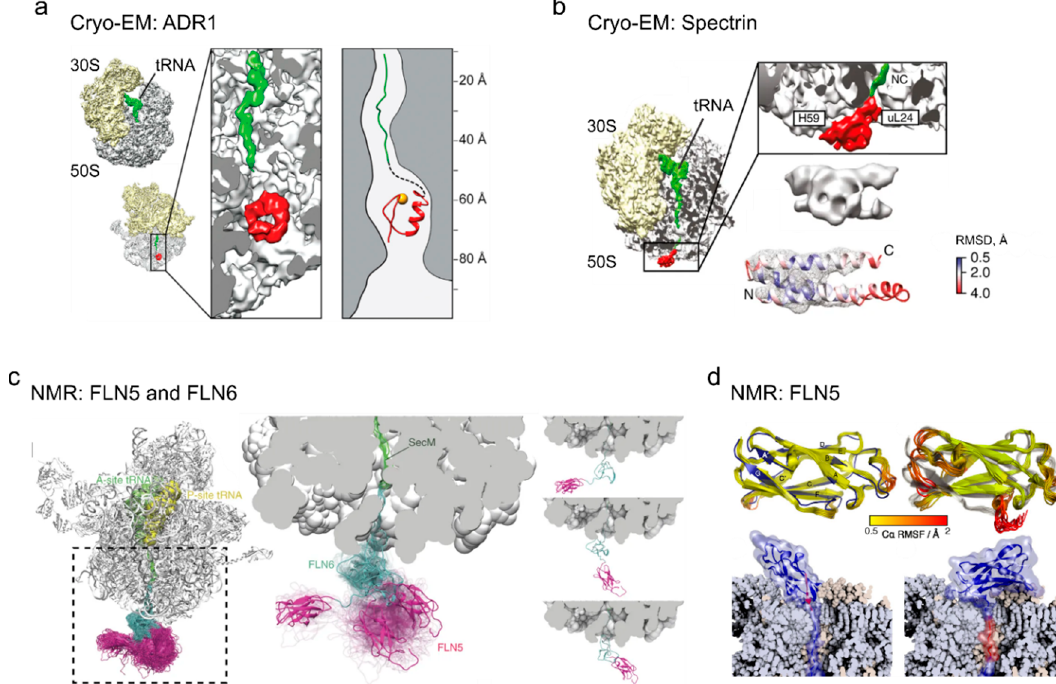
Figure 4. Tertiary structures of nascent peptides on the ribosome (adapted with permissions). ( a ) Cryo-electron microscopy (cryoEM) structure of the Zn-finger domain of ARD1 deep inside the exit tunnel of the ribosome. Figure adapted from [51]. ( b ) Cryo-EM structure of partially folded states of the spectrin domain at the exit tunnel vestibule, adapted from [16]. Root-mean-square deviation (RMSD) indicates the deviation of the native spectrin domain structure (PDB: 1AJ3) from the cryo-EM density map (EMD-3451) of the domain conformation at the ribosome surface. ( c ) Nuclear magnetic resonance (NMR) structures of the disordered FLN6 domain (cyan) and natively folded FLN5 (magenta), with representative conformations of FLN5 on the ribosome; figure adapted from [82]. ( d ) NMR structures of the native state (left) and an ensemble of intermediate states (right) for FLN5 on the ribosome [78].